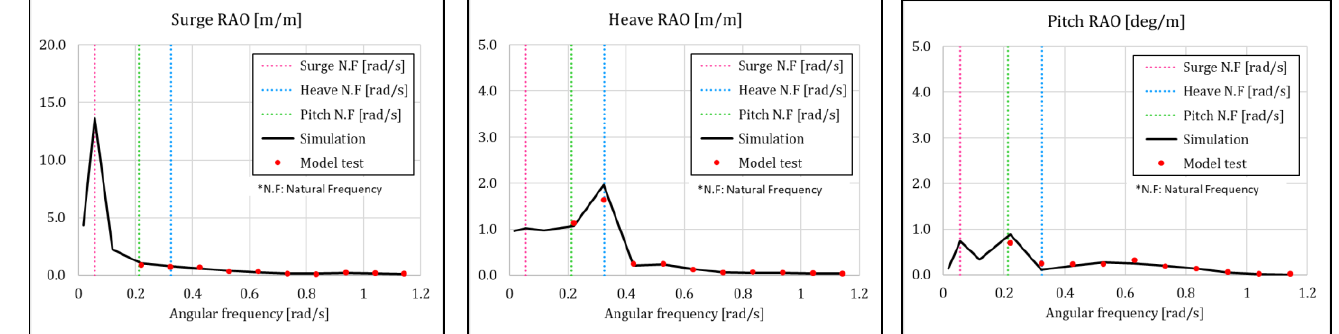
Figure 9. LC2 RAO result under wind and regular waves.